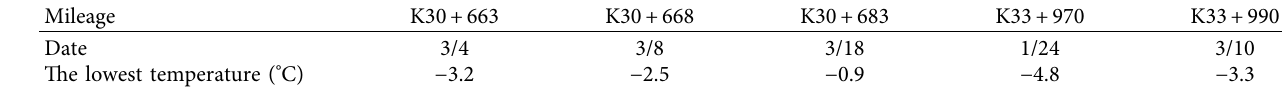
Table 2: Minimum negative temperature of testing sections.